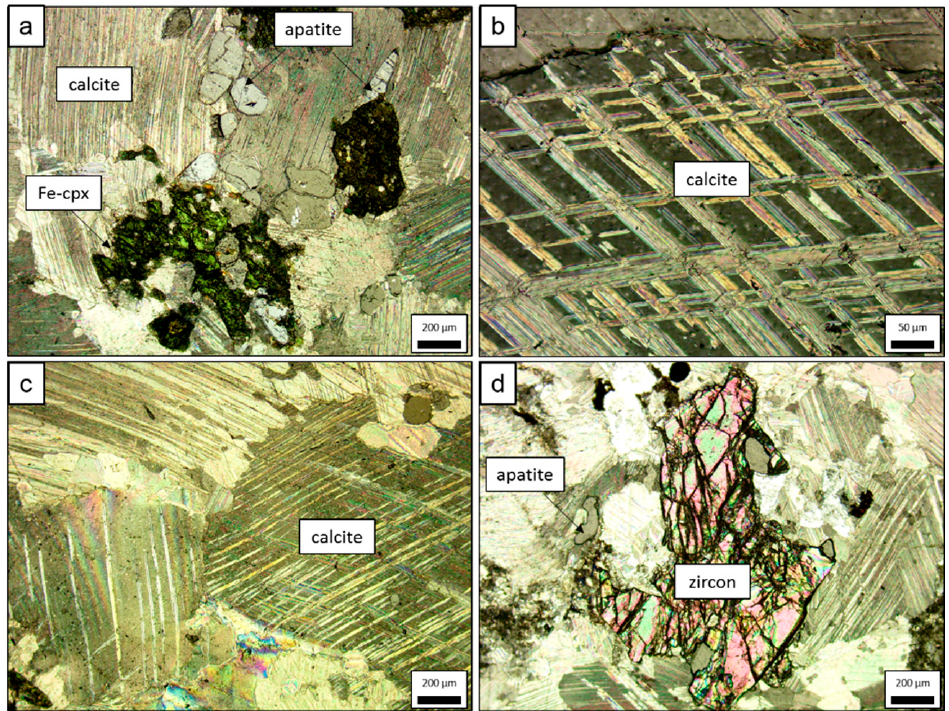
Figure 2. Microscopic aspects of Fuerteventura carbonatite textures (crossed polars). ( a ) Coarse- grained carbonatite (sövite) with Fe-clinopyroxene (dark green), calcite, and associated euhedral- rounded apatite (light grey, top center). ( b ) Detail of different grain-sizes of calcite with typical rhombohedral cleavage. ( c ) Calcite aggregates with a 120° grain boundary angle in coarse-grained carbonatite. ( d ) Zircon crystal in a medium-grained carbonatite (microsövite).